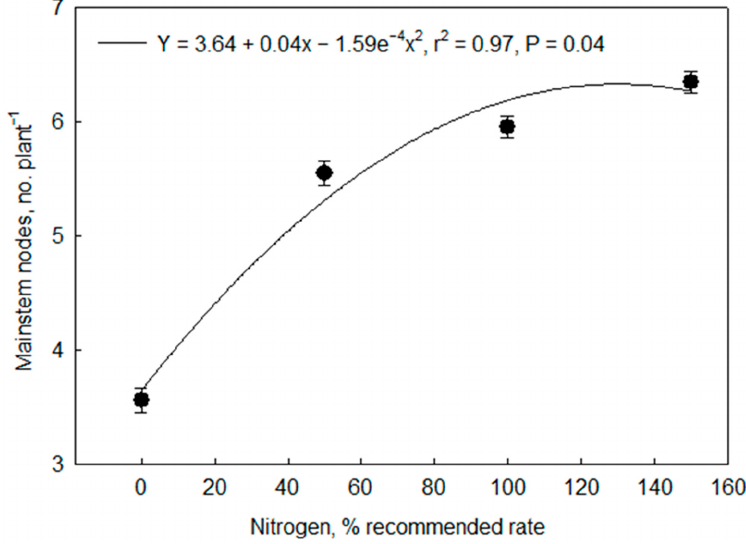
Figure 2. Nitrogen treatment effect on main stem node number (MSN) of cotton at 30 days after ± Standard error ( n = 64 plantsin total for fourreplications and two planting.Data are means ± Standard error ( n = 64 plantsin total for fourreplications and two runs). planting. Data are means